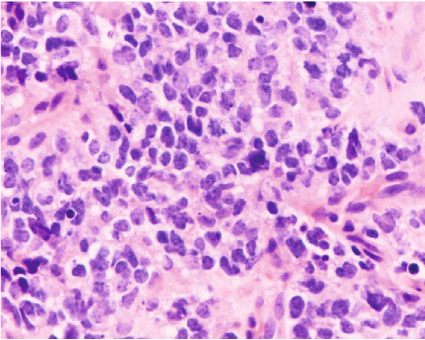
Figure 2: Histopathology with hematoxylin and eosin staining showing small round blue cells with hyperchromatic nuclei and scant amounts of ill-de fi ned cytoplasm ( × 100).